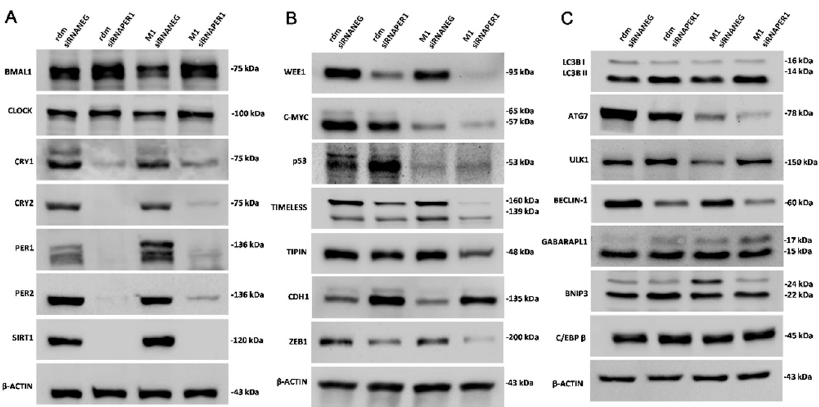
Figure 2. Western blot analysis of the expression levels of circadian proteins and regulatory proteins and transcription factors involved in key cell processes in the considered cell conditions. ( A ) Western blot analysis of the expression levels of proteins involved in the molecular clockwork. ( B ) Western blot analysis of the expression levels of proteins involved in cell processes. ( C ) Western blot analysis of the expression levels of proteins involved in the autophagic process. See the Materials and Methods section for more details. RDM siRNA NEG = siRNA scramble-treated HepG2 cells; RDM siRNA PER1 = siRNA PER1-treated HepG2 cells; M1 siRNA NEG = siRNA scramble-treated macroH2A1 knocked down HepG2 cells; M1 siRNA PER1 = siRNA PER1-treated macroH2A1 knocked down HepG2 cells; bars, standard error of mean (SEM); three biological replicates were each assayed in triplicate and results were expressed as mean ± standard error of mean (SEM). In our hands, some autophagy proteins, such as GABARPL1 and BNIP3, were in-